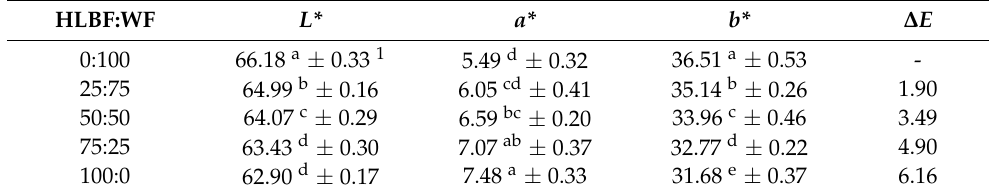
Table 3. Color of cookies made from composite flours containing wheat flour (WF) and hulless barley flour (HLBF).